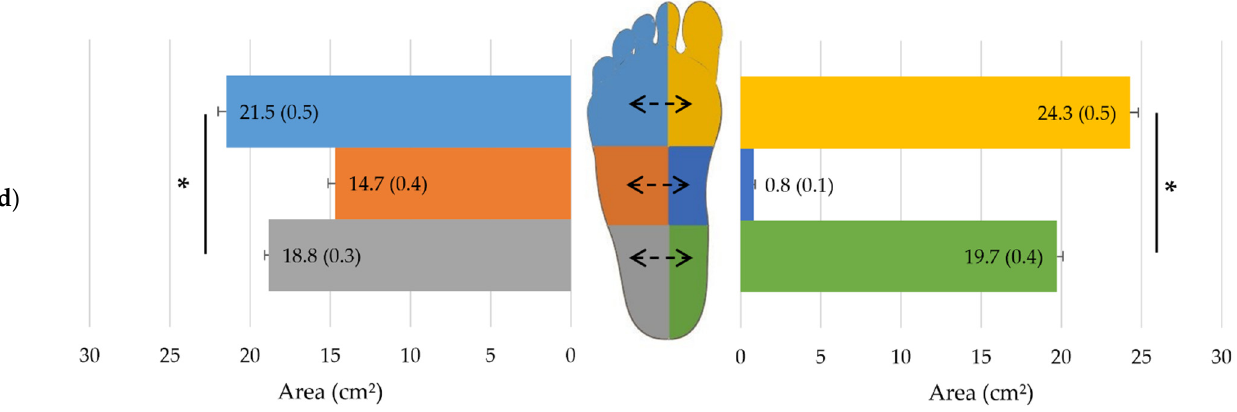
Figure 1. ( a ) Peak pressure, ( b ) P*t, ( c ) Peak time and ( d ) Area mean (and standard error) [computed for covariates at their means: age = 42.5 yrs] of each specific pressure zone; computed on all subjects ( n = 170). Asterisks (*) denote statistical significances between forefoot and rear-foot plantar pressure zones in the lateral or medial part of the foot. Significant differences between lateral and medial pressure zones of fore-, mid- and rear-foot are indicated by dashed arrows in the drawn footprint ( p < 0.05).